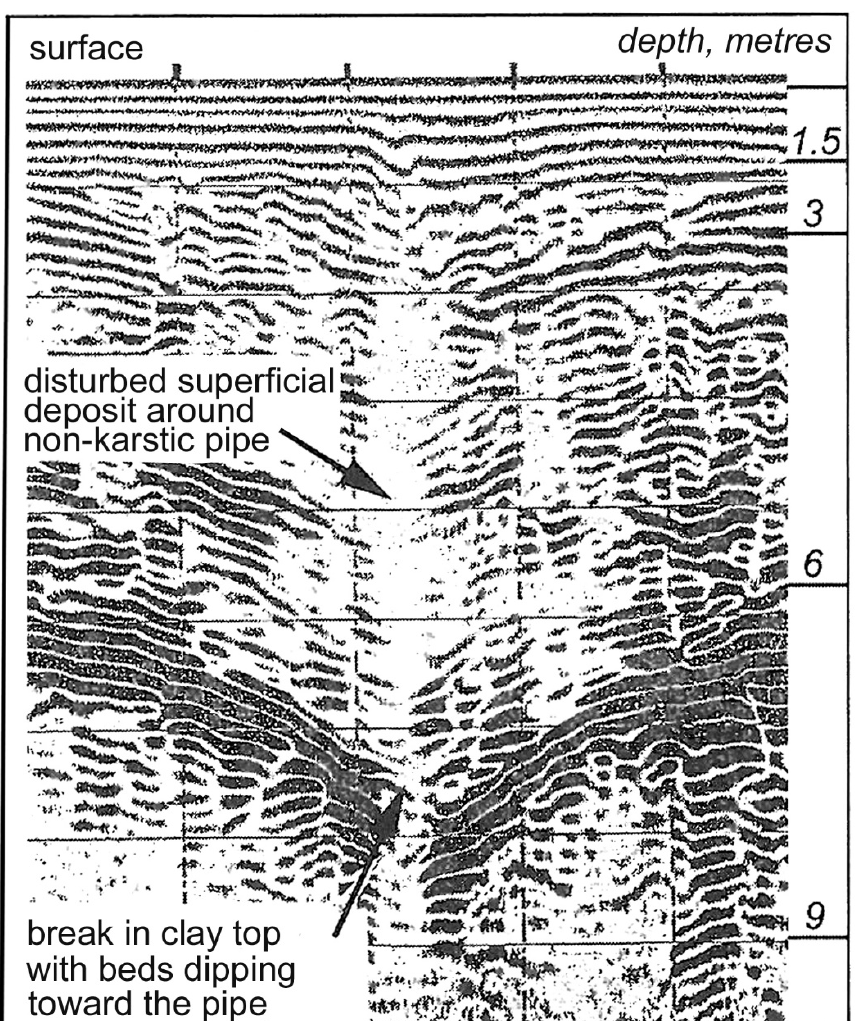
Figure 1. An image from ground probing radar that could not reach below clay [45] (modified).